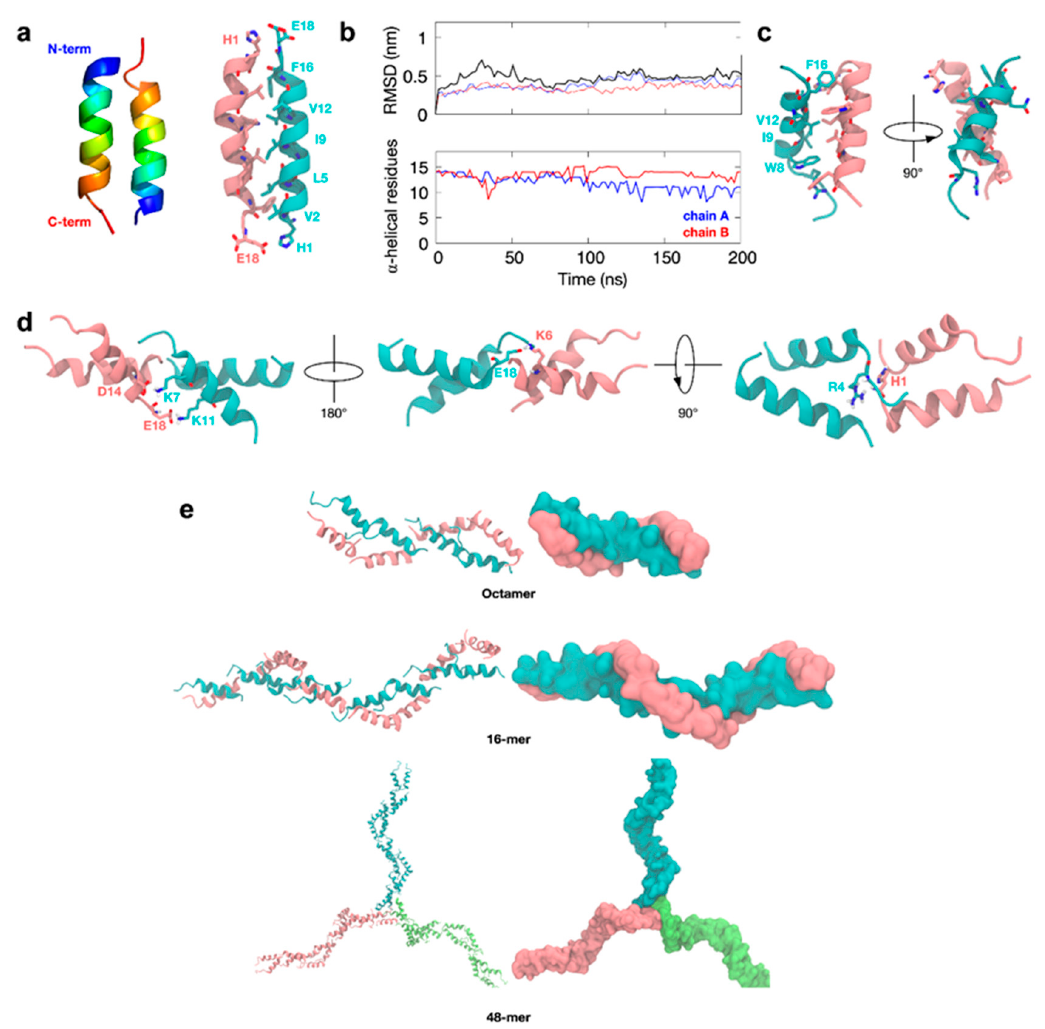
Figure 6. HVF18 idealized helix oligomerization. ( a ) A homology model of HVF18 was built as an ideal alpha-helical structure and the ClusPro program was used to generate a dimer. Two docking simulations were performed, and representative structures from the most populated clusters were aligned and colored in rainbow (left). Residues forming the dimer interface are highlighted in stick representation (right). ( b ) A 200-ns MD simulation was then performed, and the backbone root-mean-square deviation (RMSD) representing the structural drift during the simulation (top) was calculated for individual subunits (thin blue and red lines) and for the overall dimer (thick black line). The secondary structure preservation plot (bottom) shows the number of residues remaining in an alpha-helical conformation throughout the simulation for each chain. ( c ) Final image of the simulation showing residues that form the dimeric interface in stick representation. ( d ) Using the final snapshot as input for ClusPro, the structure of a tetramer was built. The representative structure of the most populated cluster is shown with the tetrameric interface highlighted in stick representation. ( e ) Octamer, 16-mer, and 48-mer structures were subsequently built using common oligomerization